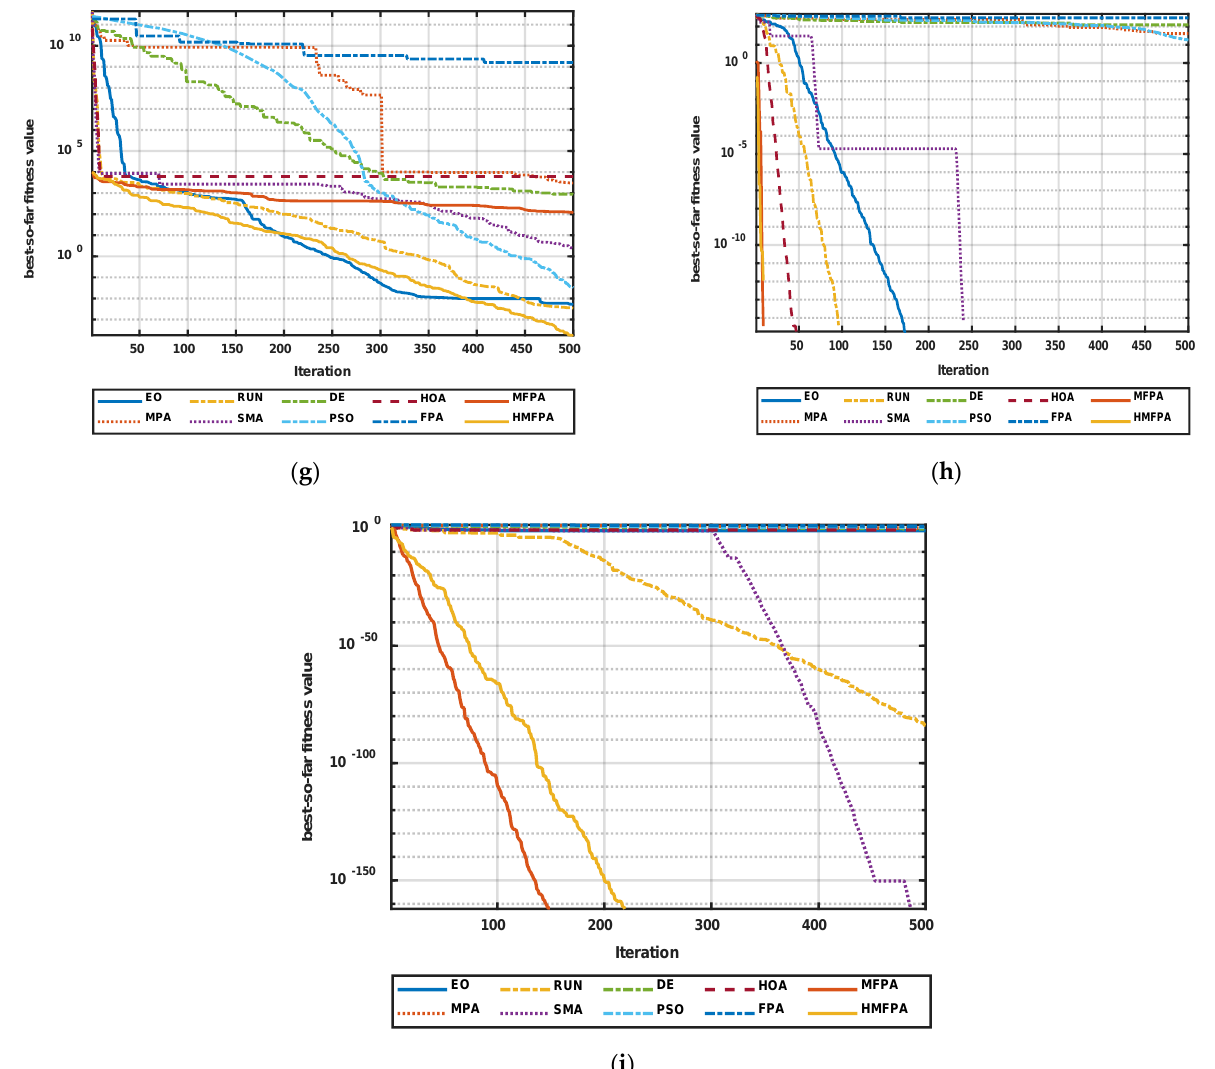
Figure 7. Convergence curve for unimodal and multimodal benchmark functions: ( a ) Convergence curve for F1; ( b ) Convergence curve for F2; ( c ) Convergence curve for F3; ( d ) Convergence curve for F6; ( e ) Convergence curve for F7; ( f ) Convergence curve for F12; ( g ) Convergence curve for F19; ( h ) Convergence curve for F20; ( i ) Convergence curve for F22.